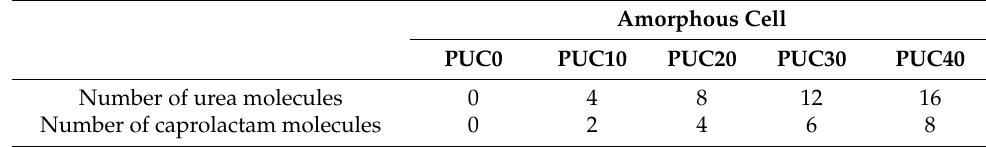
Table 1. The composition of amorphous cells.